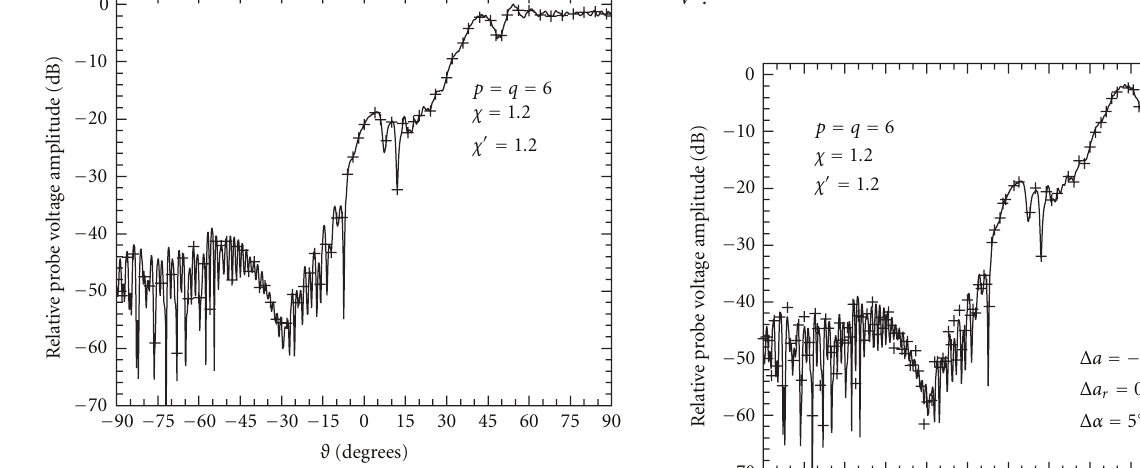
Figure 13: Normalized errors in the reconstruction of the voltage V (cid:2) .